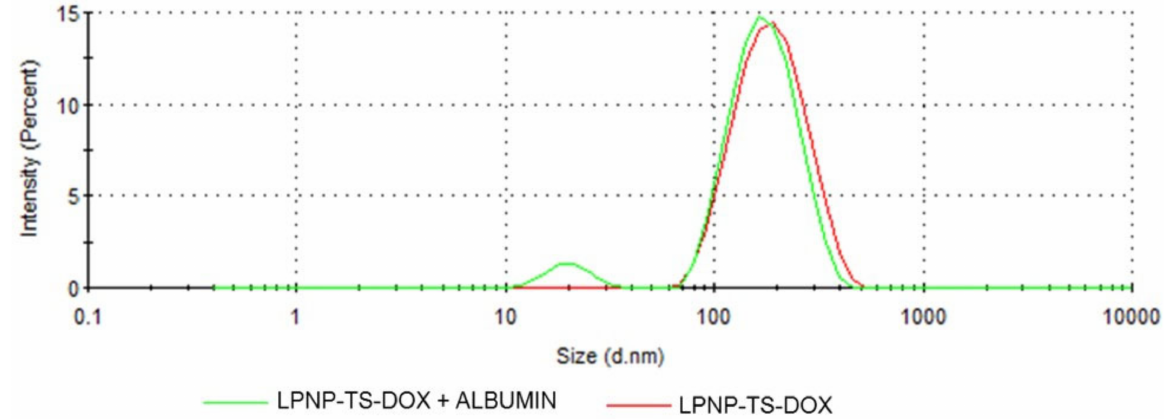
Figure 5. Stability of LPNP-TS-DOX in presence of PBS with BSA 5% w/v. Size distribution of NLP- TS-DOX (green line) and LPNP-TS-DOX + BSA (red line) were measured by dynamic light scattering.